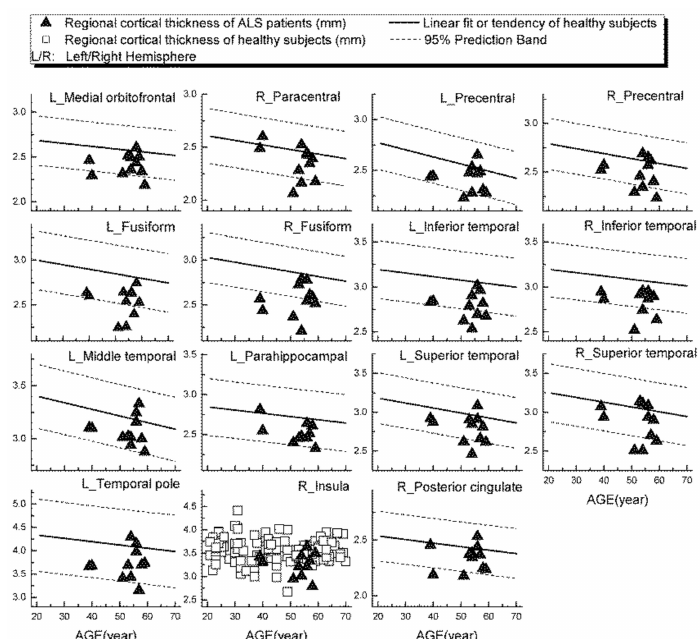
Figure 3. Regional cortical thickness (in mm) measured from ALS patients in 15 ROIs (triangular), together with the normative reference data, which were represented either by the prediction interval bands together with the linear fits or by the measured values of the healthy subjects.